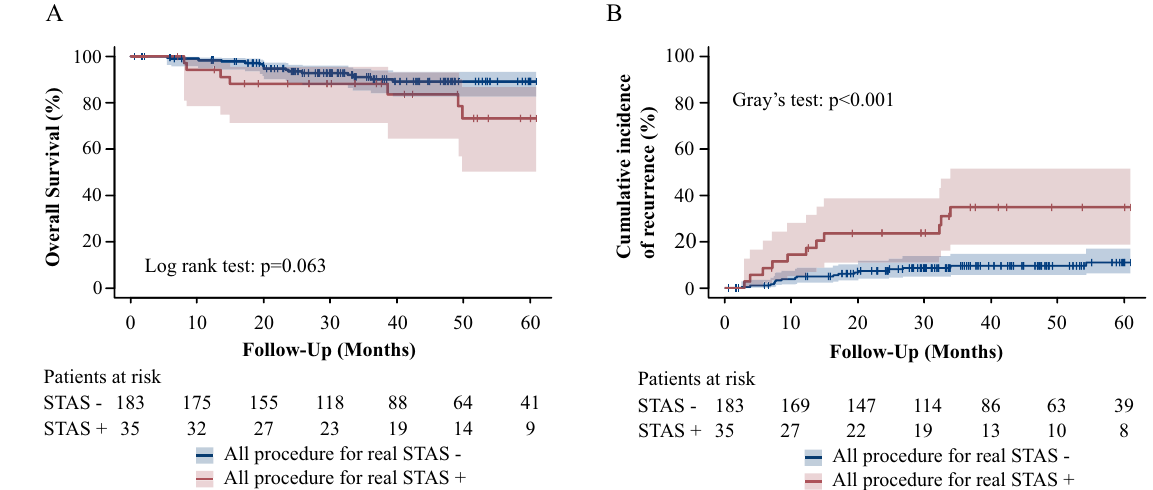
Figure 4. (R version 3.5.1, R Core Team (2018). R: A language and environment for statistical computing. R Foundation for Statistical Computing, Vienna, Austria. URL http:// www.R- proje ct. org/). The OS and CIR associated with real STAS in all procedure. Shaded areas represent 95% confidence limits. ( A ) The OS in all patients. ( B ) The CIR in all